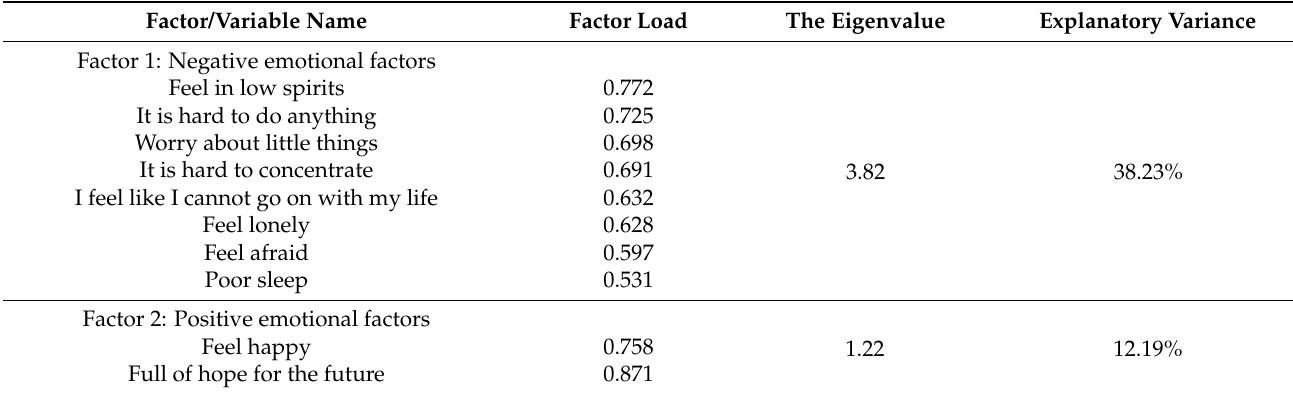
Table 1. Results of the principal component analysis.